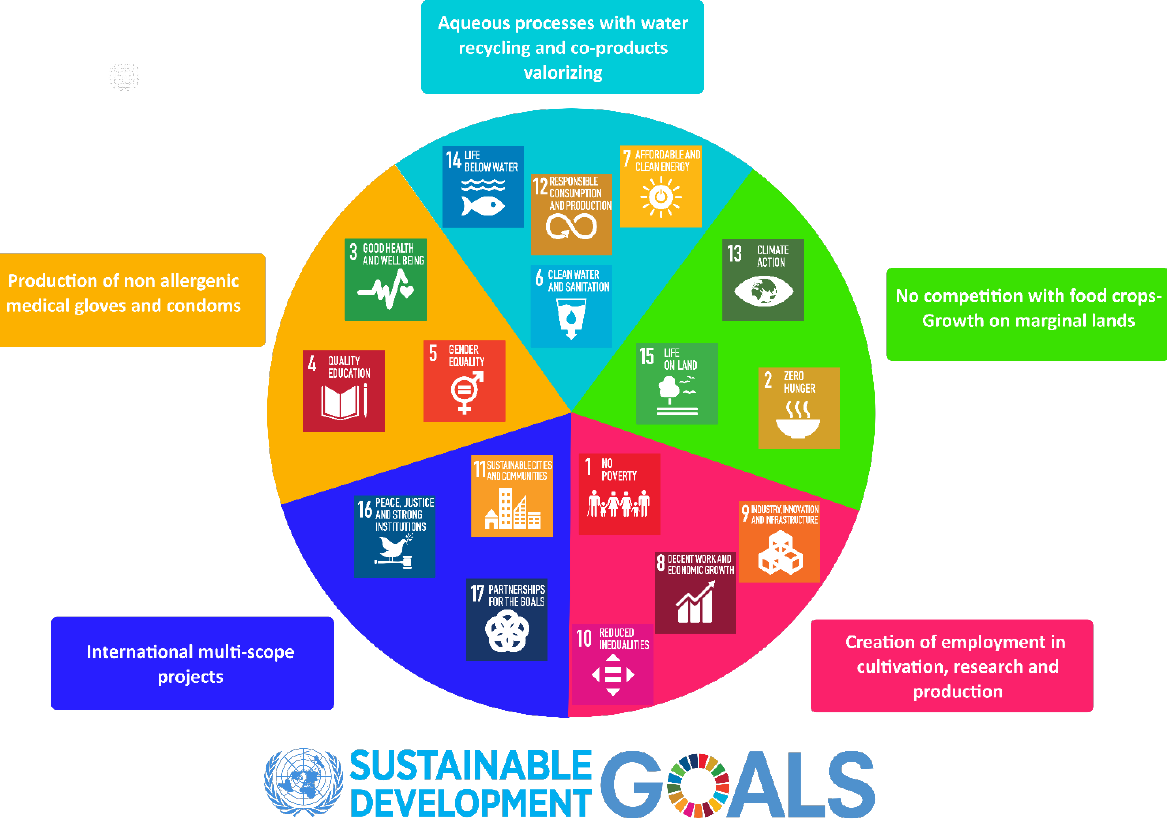
Figure 1. United Nations SDGs applied to guayule and their impacts.